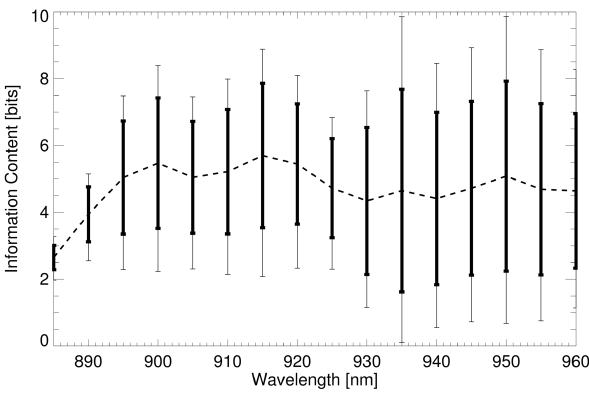
Fig. 10. Mean information content in 27 cases of different atmo- spheric circumstances concerning water vapour of a retrieval using two window channels (865, 1020 nm), a fixed first absorption chan- nel at 900 nm and a second absorption channel (width 10 nm) [broad bars account for the standard deviation of the cases].